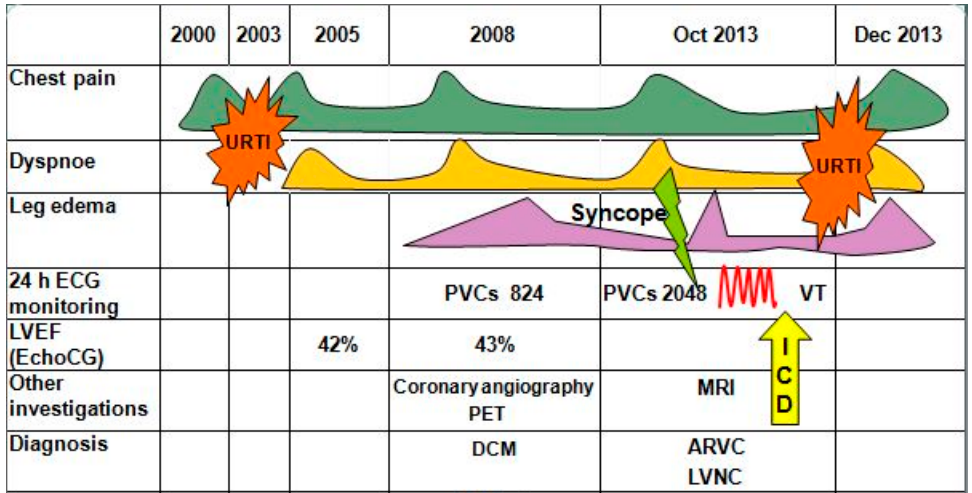
Figure 1. Scheme of the medical history (explanation in the text). ARVC—arrhythmogenic right ventricular cardiomyopathy; DCM—dilated cardiomyopathy; ECG—electrocardiography; EchoCG—echocardiography; ICD—implantation of cardioverter-defibrillator; LVEF—left ventricular ejection fraction; LVNC—left ventricular noncompaction; MRI—magnetic resonance imaging; PET—positron emission tomography; PVCs—premature ventricular contractions; URTI—upper respiratory tract infection.